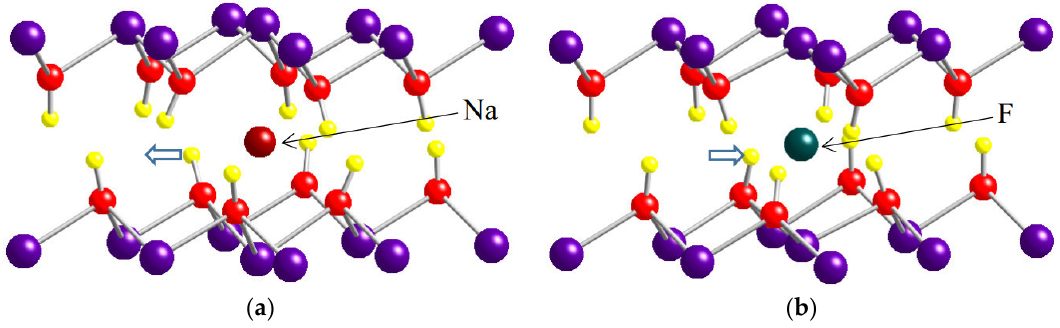
Figure 6. Atomic structure around an interlayer impurity: ( a ) Na; ( b ) F.